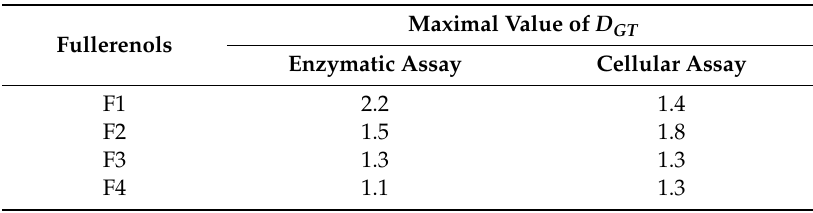
Table 3. Maximal values of D GT of fullerenols (F1–F4) in model solutions of organic oxidizer (1,4-benzoquinone) for enzymatic and cellular assays. Maximal Value of D GT Fullerenols Enzymatic Assay